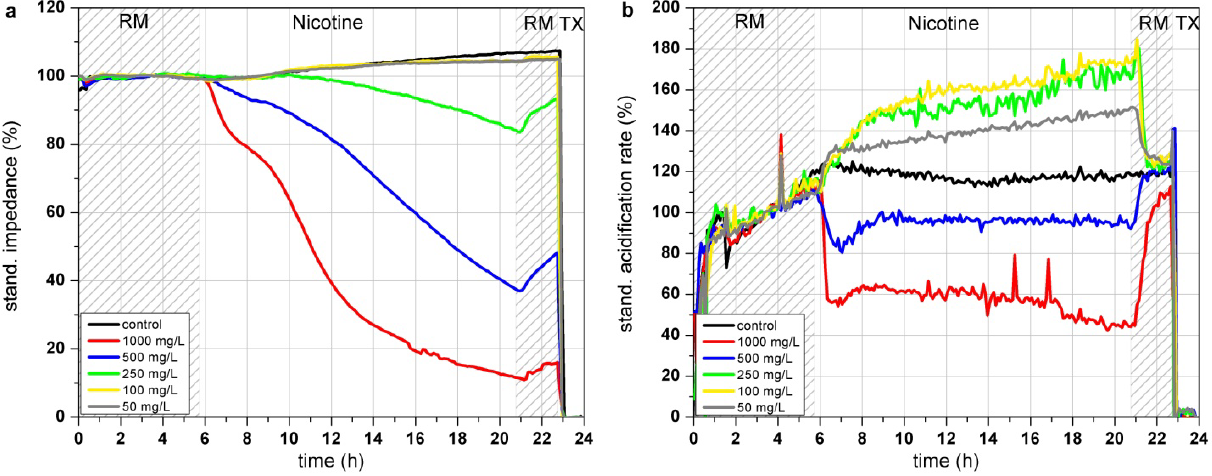
Figure 7. Time course of the impedance ( a ), acidification ( b ) and respiration ( c ) of L6 rat skeletal muscle cells during 24 h incubation with nicotine in the Bionas 2500 Analyzing System. Vehicle control (black), 1,000 mg/L (red), 500 mg/L (blue), 250 mg/L (green), 100 mg/L (yellow). Phases with running medium (RM) represent culture medium treatment without added substances. ( d ) Percent of control of impedance, respiration and acidification endpoint values measured after 15 h of nicotine exposure (n = 3). ( e ) Results of BrdU assay of L6 cells incubated with nicotine for 24